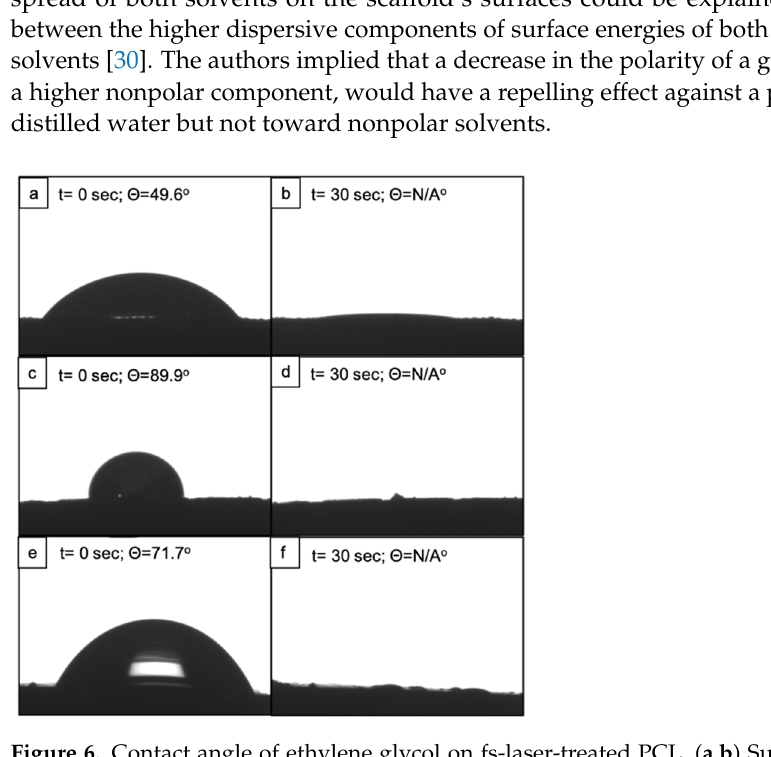
Figure 6. Contact angle of ethylene glycol on fs-laser-treated PCL. ( a , b ) Surface with microchannels (F = 0.08 J/cm 2 ; N = 10); ( c , d ) Surface with microprotrusions (F = 0.08 J/cm 2 ; N = 2); ( e , f ) Control scaffold.